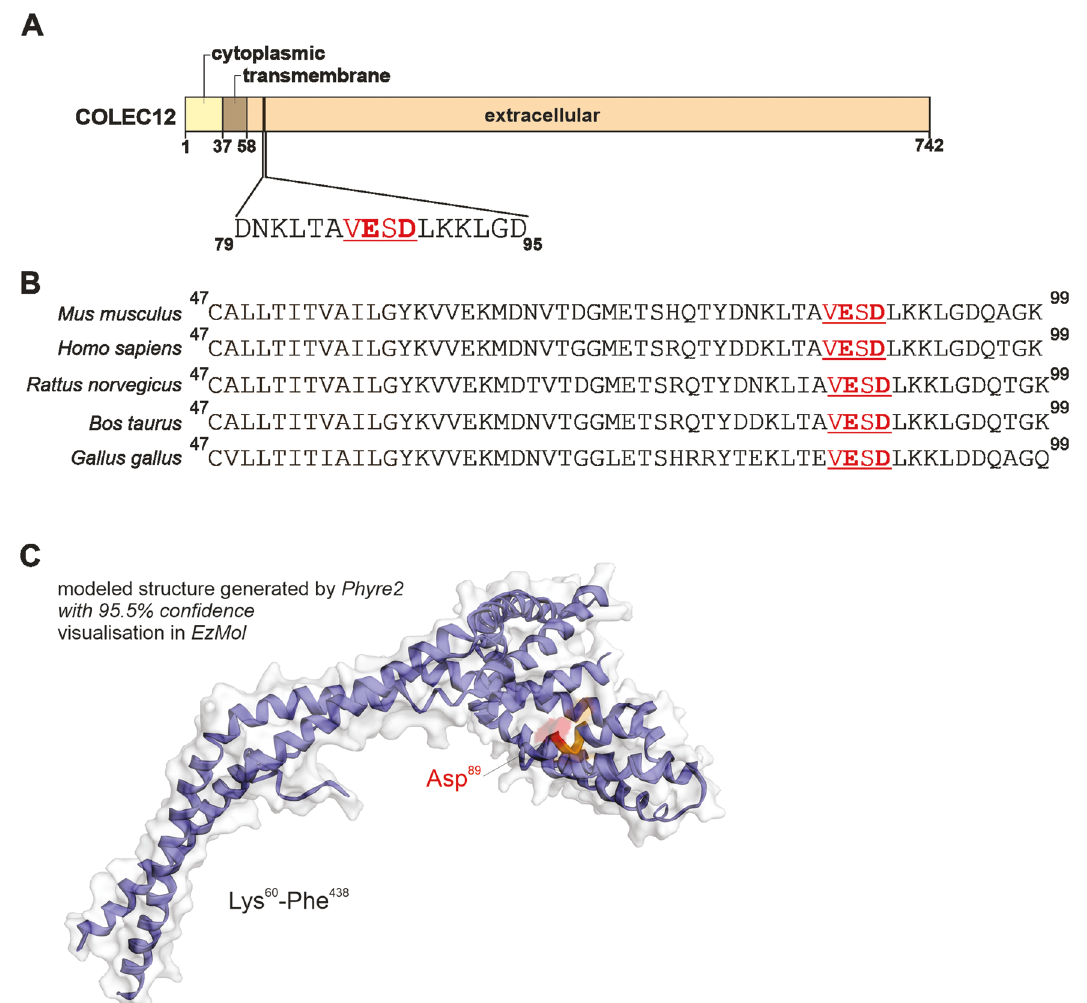
Fig. 4 Potential CASP3 cleavage site in COLEC12 protein. A Schematic diagram of the functional domains and the potential CASP3 cleavage site in COLEC12. The full-length COLEC12 protein contains an intracellular (yellow), a transmembrane (brown) and an extracellular (orange) domains. B Using the prediction tools SitePrediction and Procleave, a conserved CASP3 substrate cleavage site (VESD.LK) at amino acid 86 with >99% speci fi city was identi fi ed in COLEC12 protein sequence from several species. C 3D modeling of 378 residues of the COLEC12 protein. The VESD cleavage site is highlighted in orange with the Asp (D) residue in